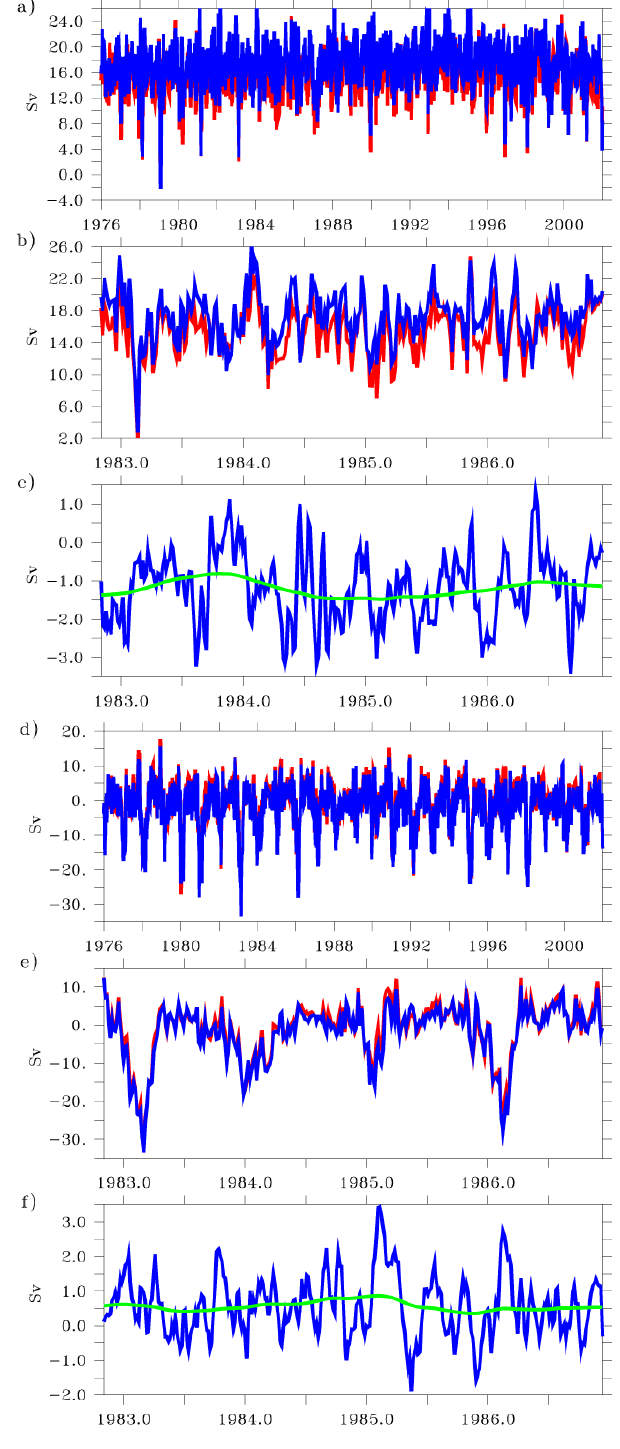
Fig. 7. MOC time series at 26 ◦ N for experiment A025 (blue) and B025 (red) for (a) , (b) , (c) the Atlantic and (d) , (e) , (f) Indo-Pacific. (a) , (d) 5-day MOC averages at 1000m for 1976 to 2001. (b) , (e) zoom on the years 1983 to 1987. (c) , (f) MOC differences between √ A025 and B025 scaled by 1 / 2 as unfiltered (blue) and smoothed values. The smoothing was done using a Parzen filter with a window length of 505 days